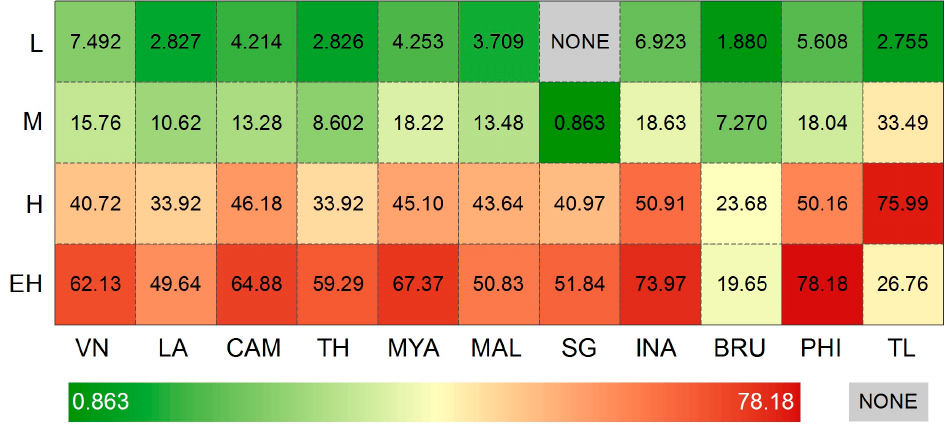
Figure 10. Area percentages (%) of radar-derived human settlements of 2012 in different nighttime lighting areas for 11 Southeast Asian countries.